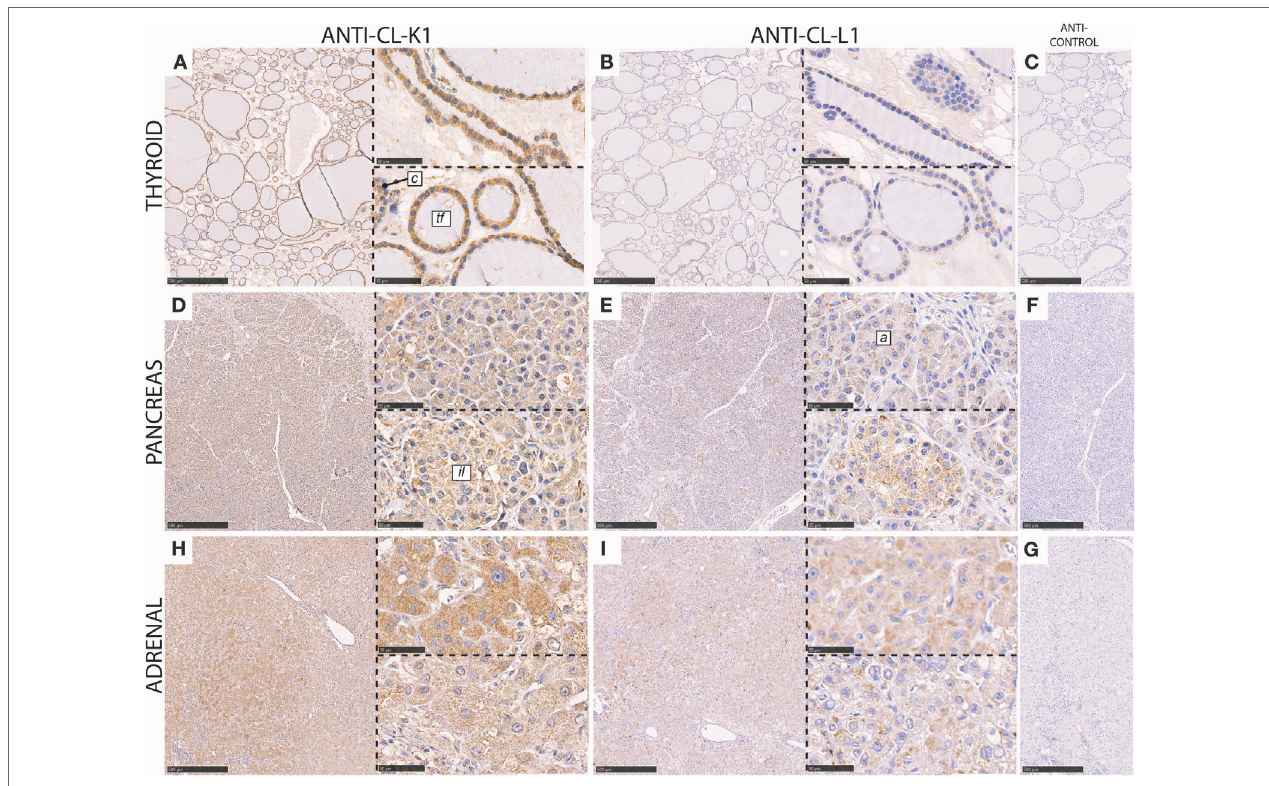
FigUre 4 | Immunohistochemical localization of CL-K1 and CL-L1 in formalin fixed and paraffin embedded sections of the thyroid gland (a,B) , pancreas (D,e) , and adrenal gland from a patient diagnosed with pheochromocytoma, (h,i) . Italic letters within images refer to: for the thyroid gland tf , thyroid follicles and c , parafollicular C cells; pancreas il : islets of Langerhans and a : acinar epithelial cells. Scale bars in large sections and in isotype control sections (c,F,g) correspond to 500 µm and in small sections to 50